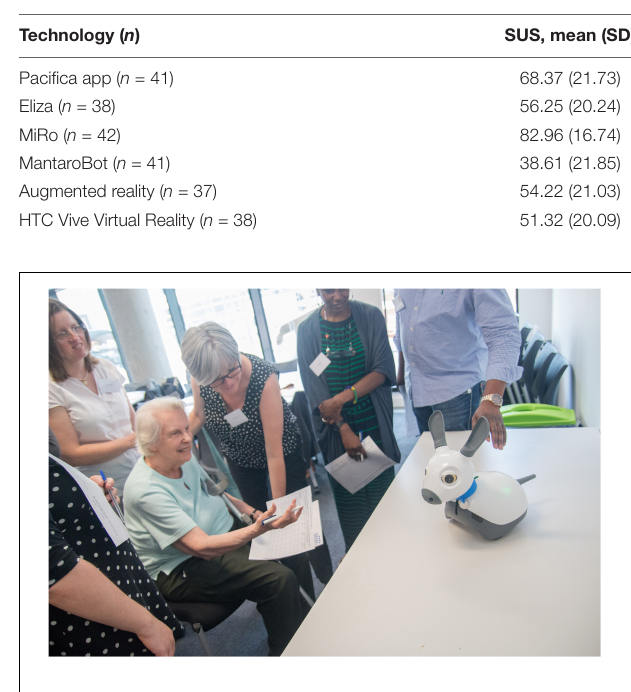
82.96 (SD 16.74) and ‘Pacifica’ with a mean of 68.37 (SD